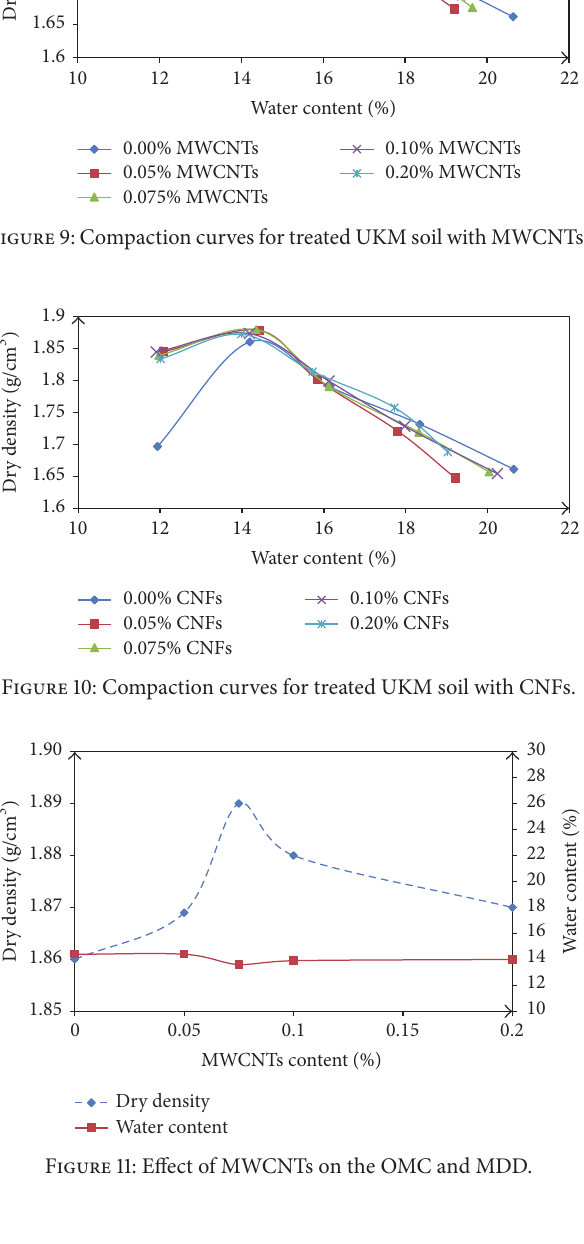
from 2.16𝐸 − 09 m/s to 9.46𝐸 − 10 m/s for soil